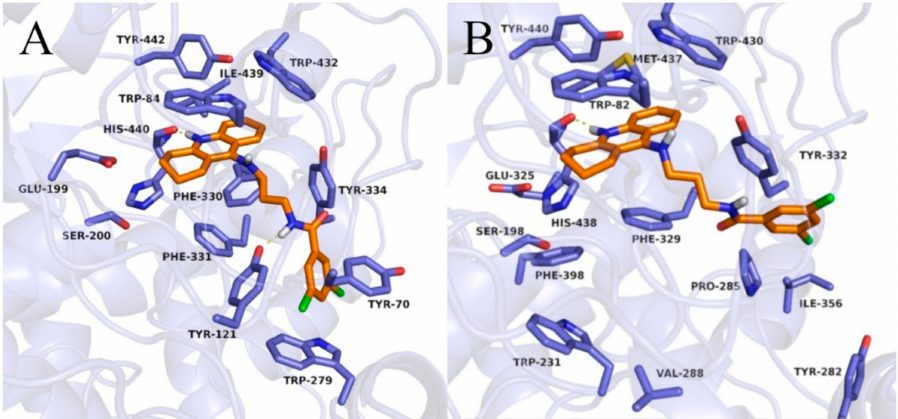
Figure 5. Binding mode of compound 3b within acetylcholinesterase ( A ) and butyrylcholinesterase ( B ).